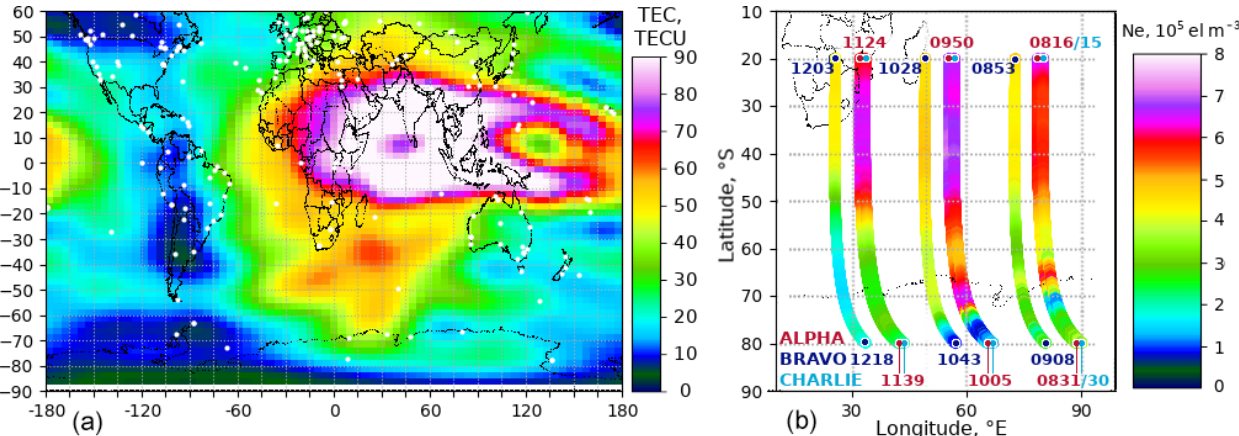
Figure 7. A LTE on 18 April 2014 that was observed in the GIM (a) and in in situ measurements of N e by SWARM satellites (b) .